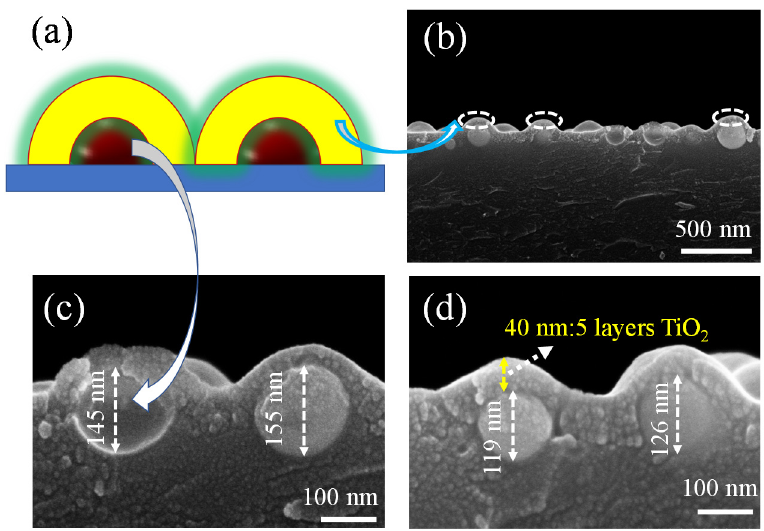
Figure 3. ( a ) Schematic illustrations of the Cu/TiO 2 composite film: the arrows represent copper nanoparticles and TiO 2 films, respectively. ( b ) SEM side-view of the Cu/TiO 2 composite film. ( c , d ) Enlarged SEM side-views of the Cu nanoparticles covered with TiO 2 of varying thickness.